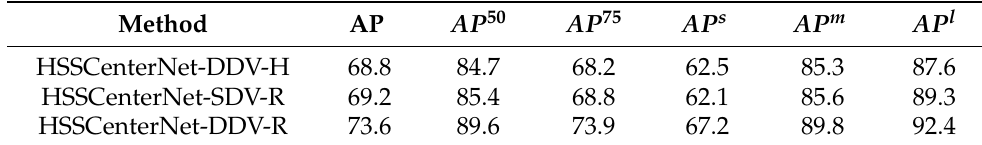
Table 3. Validation experiments on the regression mechanism of tilted boxes. -SDV: a sloping box regression mechanism using only a single direction vector; -DDV: a sloping box regression mechanism using dual direction vectors. -H: using the horizontal box label to train the tilted bounding box detection task, that is to say, the angle is fixed at θ ; -R: using the tilted box label to train the tilted 2 bounding box detection